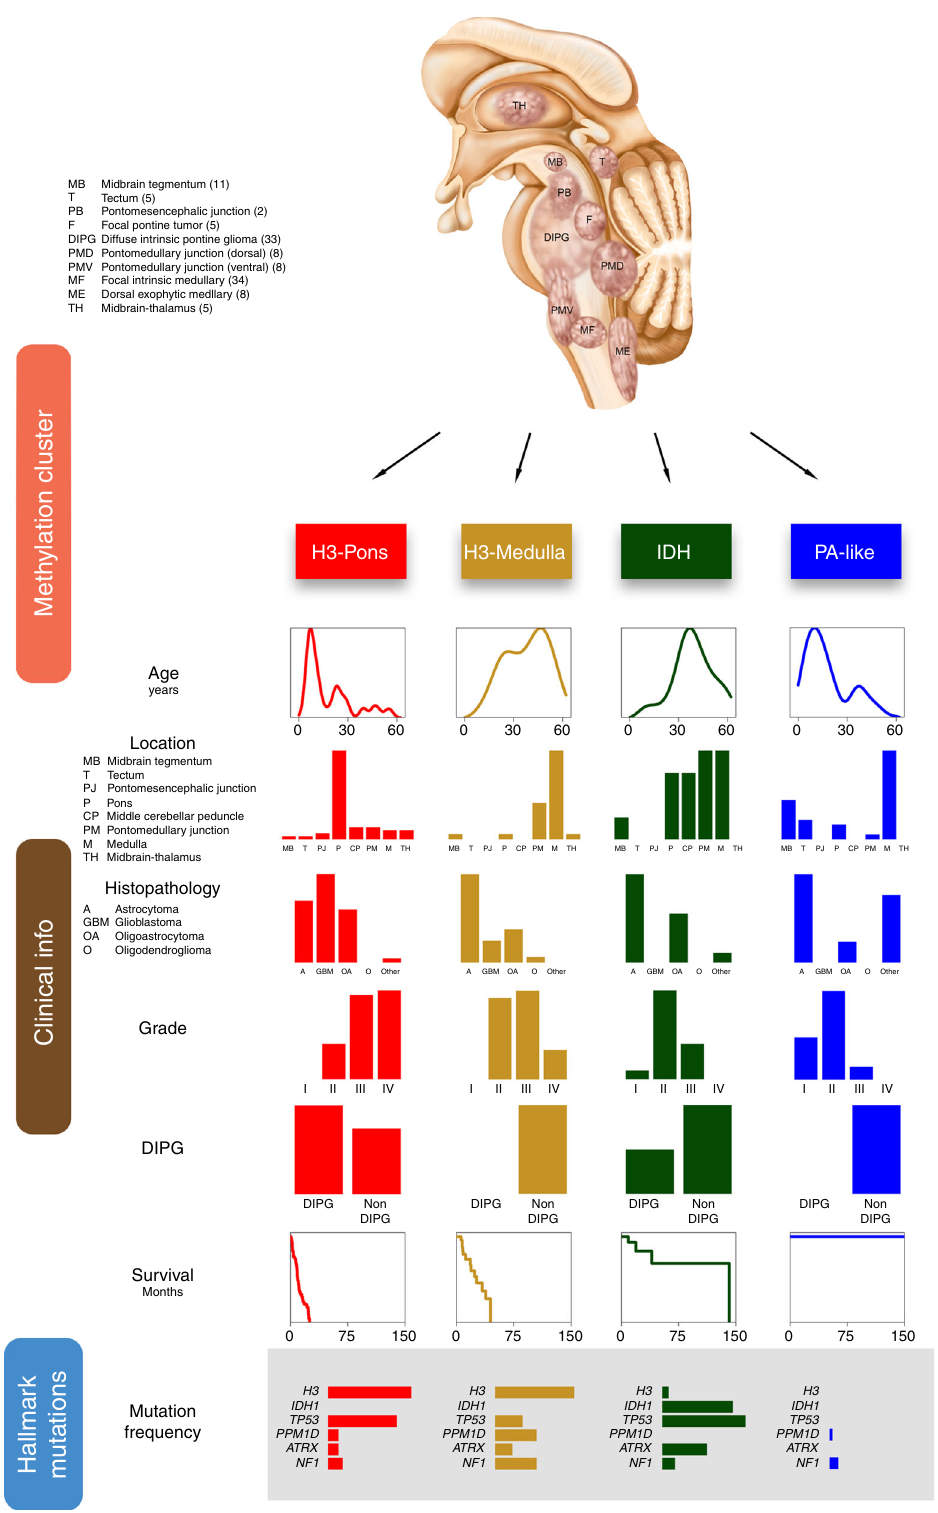
Fig. 7 Overview of subtypes of brainstem glioma Integrative analysis of brainstem gliomas revealed four different subtypes with distinct clinical, genetic, and epigenetic characteristics. The illustration on the top shows the locations of tumors selected for this study. Numbers in the parentheses indicated case counts in the code index respectively. Based on methylation patterns, brainstem gliomas could be differentiated into four subtypes: H3-Pons, H3-Medulla, IDH, and PA-like. Clinical information was listed in columns. Tumor location, histopathology, grade, and diagnosis of DIPG are showed in frequency as barplots. Survival data was showed as Kaplan – Meier curves, and age at diagnosis is represented as density plot. Several hallmark mutations are selected and showed in frequency as